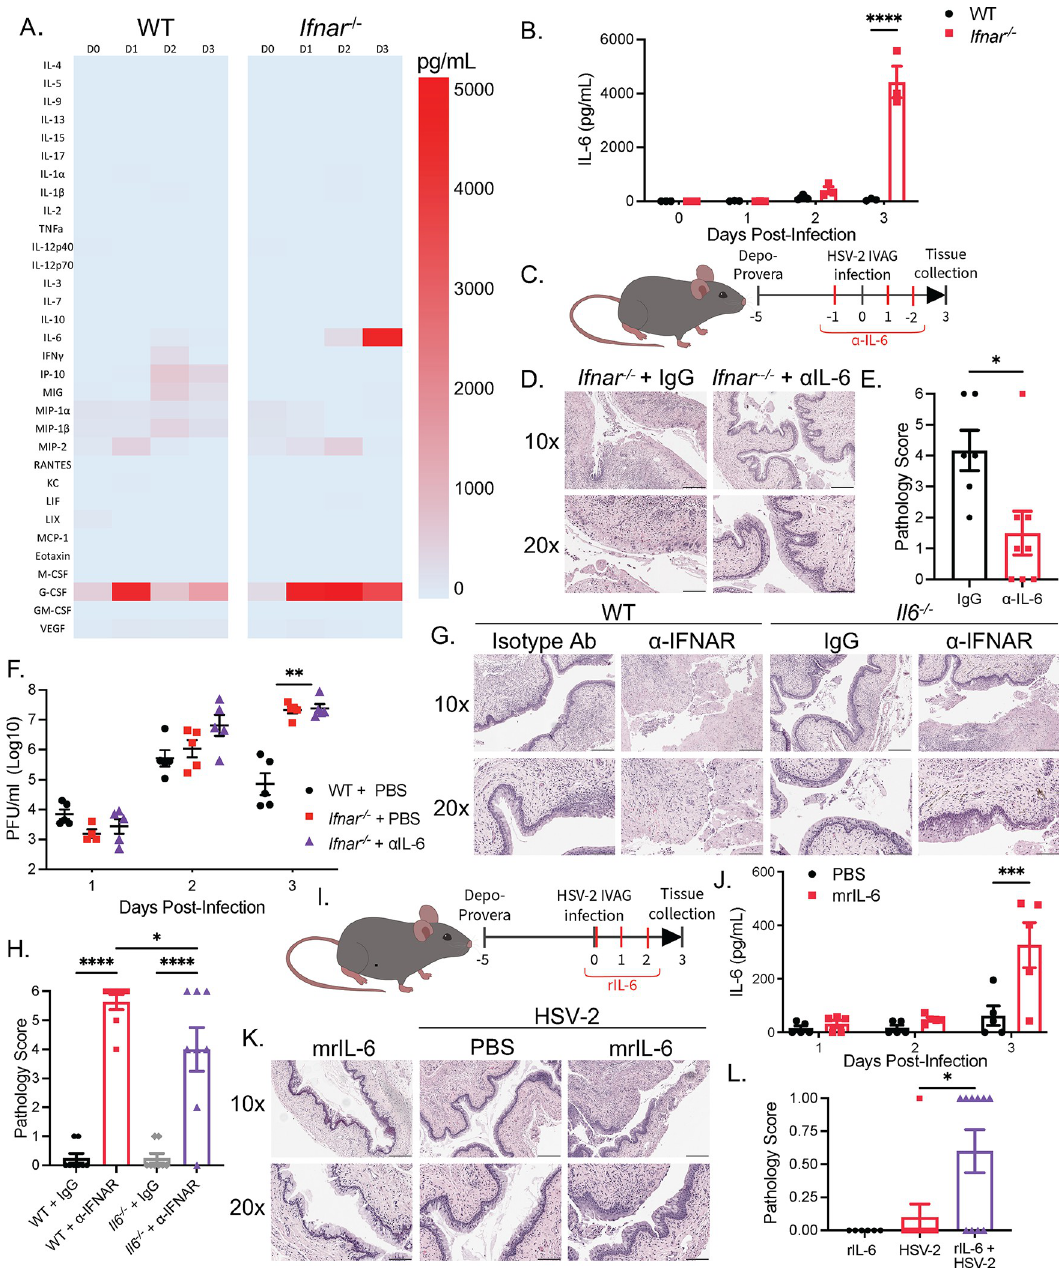
Fig 4. Type I IFNs regulate IL-6 production to prevent macrophage-mediated immunopathology during viral infection. (A) Heatmap of cytokine production in vaginal washes following HSV-2 infection. (B) IL-6 cytokine levels in vaginal washes of WT and Ifnar -/- mice following HSV-2 infection at 0 to 3 dpi (n = 3). (C) Ifnar -/- mice were administered control IgG Ab or α -IL-6 Ab during intravaginal HSV-2 infection. (D and E) H&E staining (D) and pathology score (E) Ifnar -/- + IgG, and Ifnar -/- + α -IL-6 treated mice at 3 dpi (n = 4–5). (F) Viral titers of WT, Ifnar -/- + IgG, and Ifnar -/- + α -IL-6 treated mice at 0 to 3 dpi. (G and H) H&E staining (G) and pathology score (H) of WT and Il6 -/- mice administered isotype IgG or α -IFNAR Ab at 3 dpi. (I) Uninfected and infected WT mice were administered control or mrIL-6 during HSV-2 infection. (J) IL-6 in vaginal washes in PBS and mrIL-6 treated WT mice (n = 5). (K) H&E staining of HSV-2-infected and uninfected WT mice with or without mrIL-6 treatment (n = 5). (L) Pathology score of (K). 10x scale bar represents 200 μ m, 20x scale bar represents 100 μ m. Data in (B), (E), (F), (H), (J), and (L) are represented as mean ± SEM. � p < 0.05, �� p < 0.01, ��� p < 0.001, and ���� p < 0.0001 (B, F, H, J, two-way ANOVA; L, one-way ANOVA; E, two- tailed t-test). See also S4 Fig.